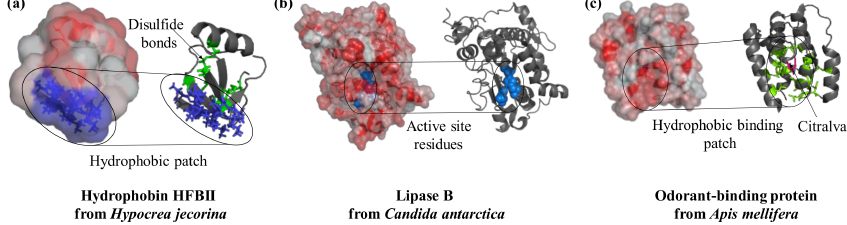
Figure 1. Surface features play a crucial role in the function of proteins. Hydrophobins interact with substrates in a specific region of the structure that is rich in hydrophobic residues (PDB ID: 2b97, blue). Lipases are active enzymes on hydrophobic substrates; they catalyze the hydrolysis of triacylglycerides and their active site (key residues in blue and spheres) is located in a hydrophobic protein patch (PDB ID: 4k6g). Similarly, the odorant-binding protein from bees has a hydrophobic cleft (residues in green as sticks) at the center of the molecule to bind the perfume-like water-insoluble molecule citralva (in pink sticks, PDB ID: 3s0d). Protein structures are visualized with Pymol (The PyMOL Molecular Graphics System, Version 1.2r3pre, Schrödinger, LLC.), surface hydrophobicity was analysed by running the script “color_h” [19] and surface electrostatic potential with the APBS plugin